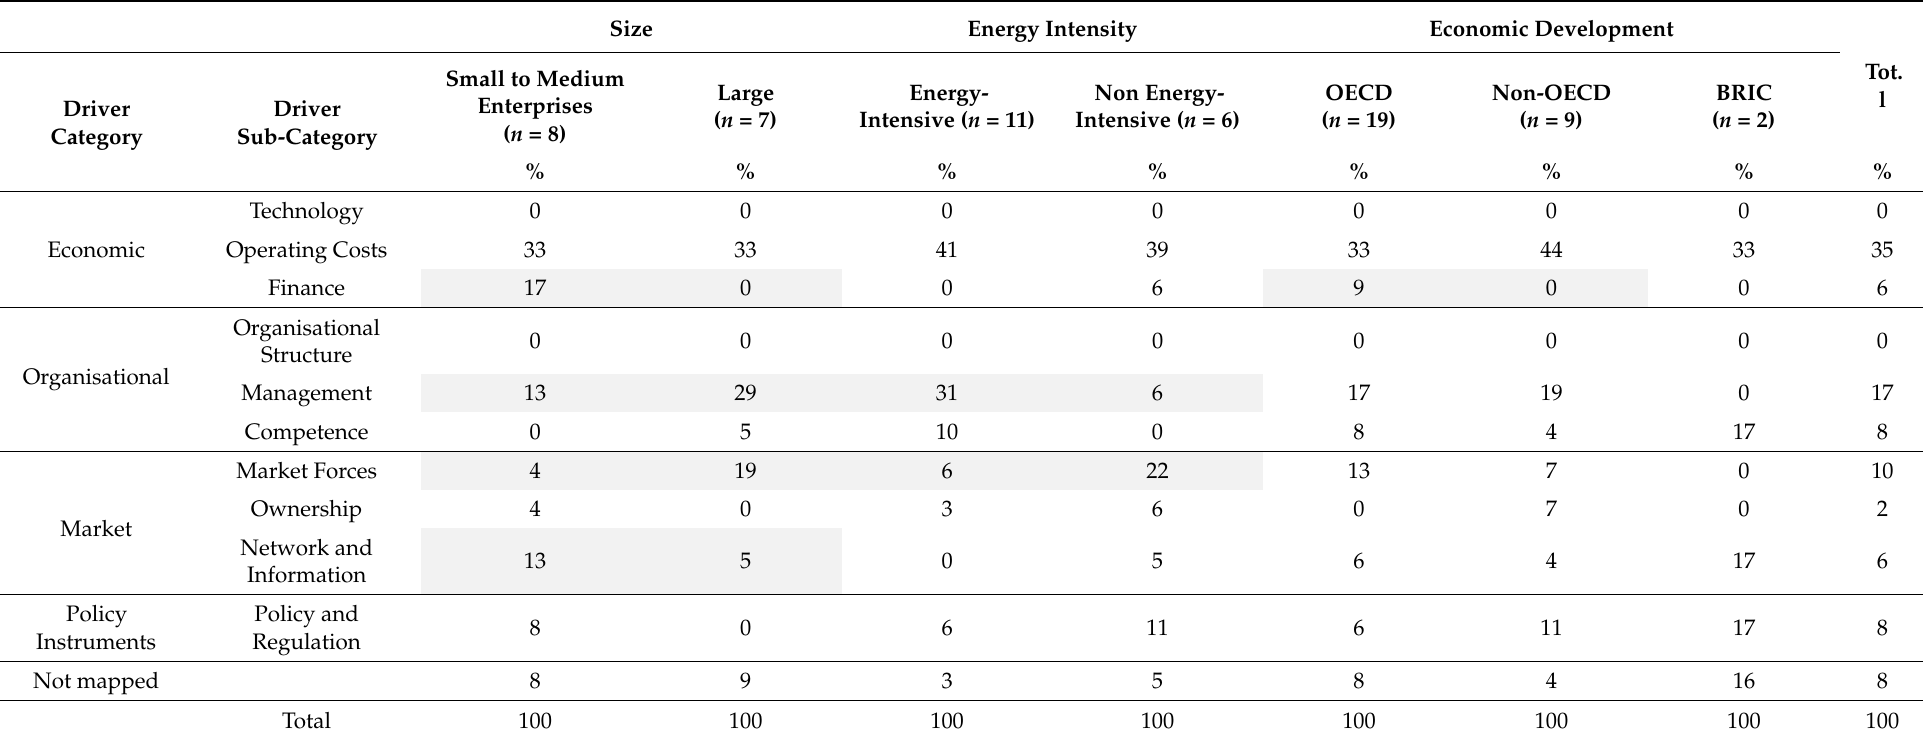
Table 5. Sub-category level mapping with results divided by size, energy intensity and economic development. Categories which show a significant difference have been highlighted. Driver categories and sub-categories are from [16].